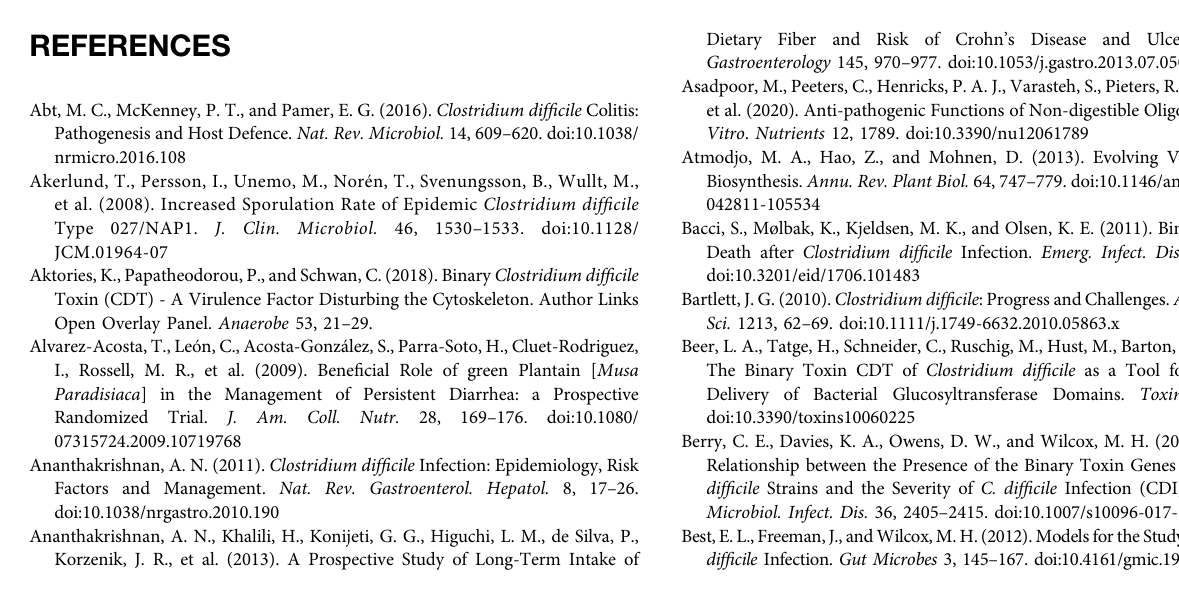
Supplementary Figure S1 | Visualisation of puri fi ed C. dif fi cile spores. Supplementary Figure S2 | Soluble plantain NSP acts on the epithelium to inhibit the interaction of diarrhoeal pathogen C. dif fi cile. Supplementary Figure S3 | Plantain NSP induces cellular chloride ion channel activity inintestinalcells inadose-dependentmanner,but inhibition ofchloride ef fl ux doesnotinhibitplantainNSP-inducedblockadeof C.dif fi cile -epithelialcelladhesion. Supplementary Figure S4 | Treatment of murine intestinal organoids with C. dif fi cile toxins A (TcdA) and B (TcdB) induces cell rounding. SupplementaryFigureS5 | C.dif fi cile toxinsA(TcdA)andB(TcdB)mediatemono- glucosylation of intracellular Rac1 in intestinal epithelial cells. Supplementary Figure S6 | Soluble plantain NSP reduces C. dif fi cile binary toxin mediated in fl ammation, and cytotoxicity in Intestine-407 cells. Supplementary Table S1 | Compositional data of soluble non-starch polysaccharides (NSP) derived from dietary sources. SupplementaryTableS2 |SporulationcharacteristicsofC.dif fi